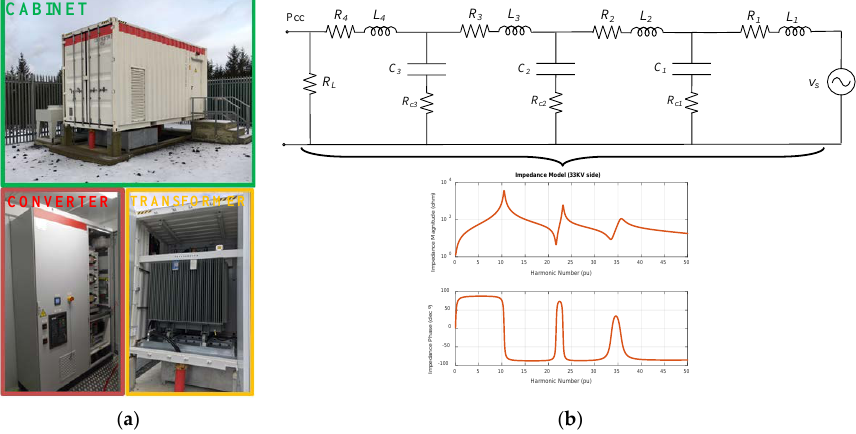
Figure 23. Experimental setup and equivalent impedance of AC grid (a) A picture of the converter, transformer, and location of the ACISEF, ( b ) estimated equivalent impedance of the AC grid at the point where the ACISEF is connected (Pcc) and adapted equivalent electric model (seventh order model approach).